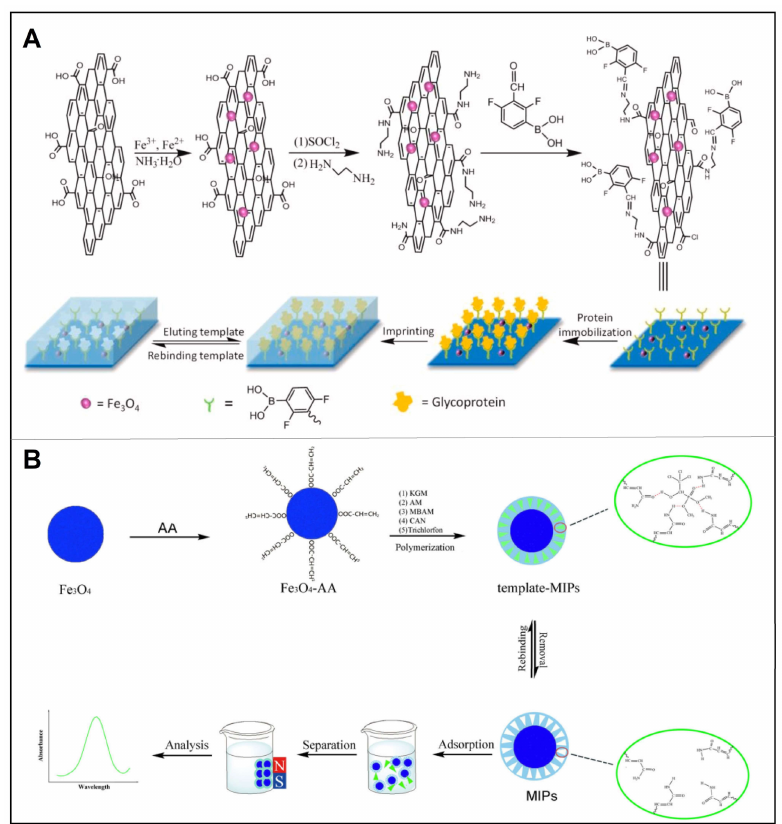
Figure 6. ( A ) Schematic illustration for preparation of a novel type of MMIP for selective extraction of glycoprotein at physiological pH. Reproduced with permission from [52]. ( B ) Preparation of core/shell magnetic MIPs and their application. Reproduced with permission from